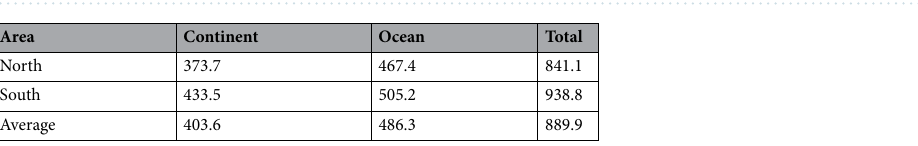
Table 4. Average of precipitable water (PW) vapor in mm day −1 over each area indicated in Fig. 4e–g. The areas are over the continent, the ocean, and the total area that considers the two previous ones, for the oceanic SACZ cases.